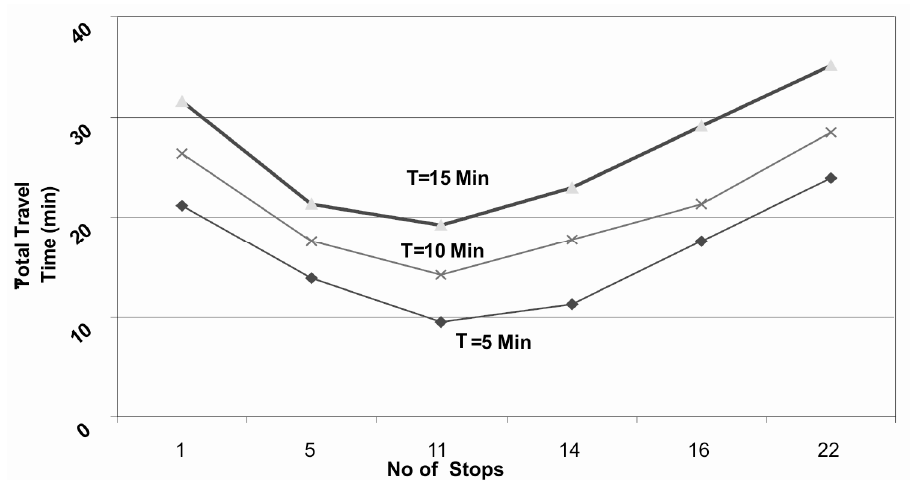
Fig 3. Total travel time plotted for a number of stops for various users of vehicle